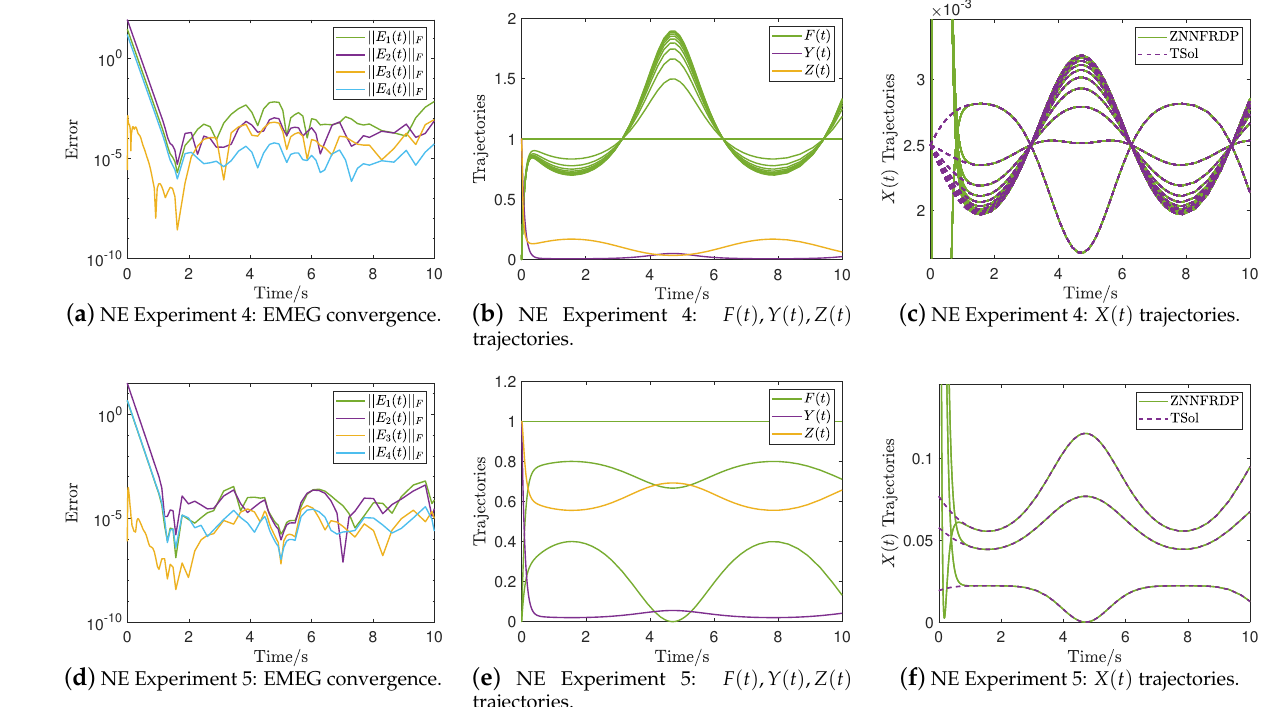
Figure 4. EMEG convergence and solutions’ trajectories of the ZNNFRDMP model in NEs in Sections